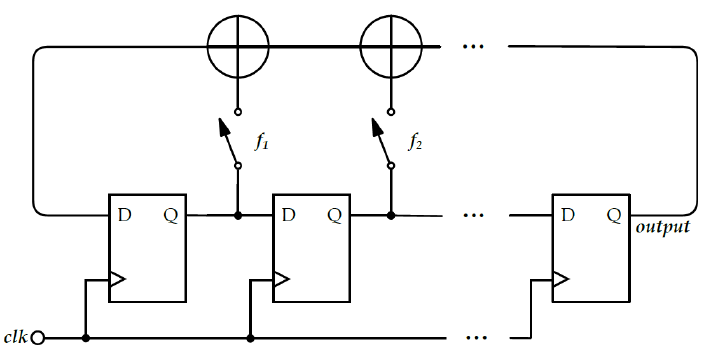
Figure 3. Fibonacci Linear Feedback Shift Registers.